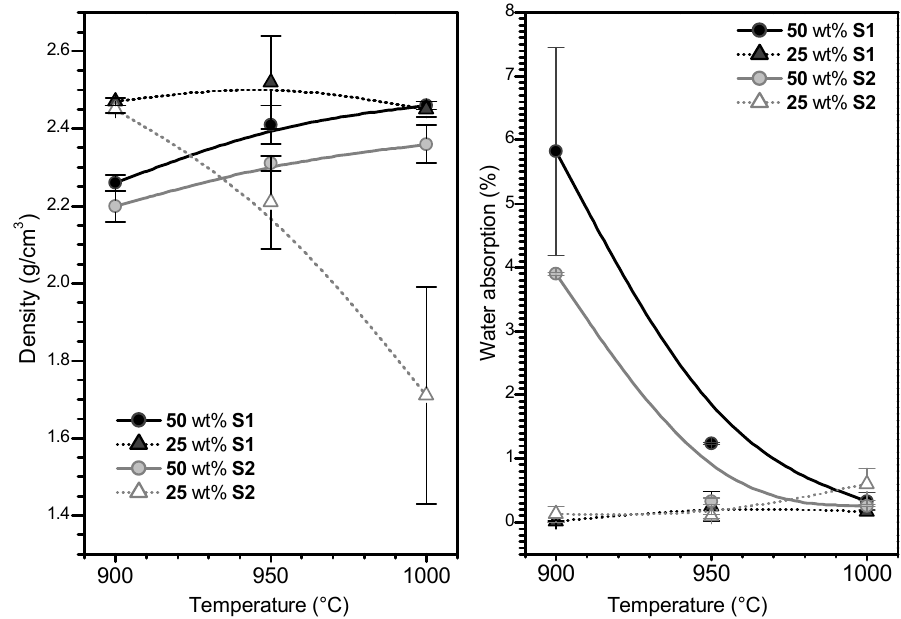
Figure 1. Density and water absorption evolutions with composition and temperature (B-spline lines are provided simply as guides for the readers’